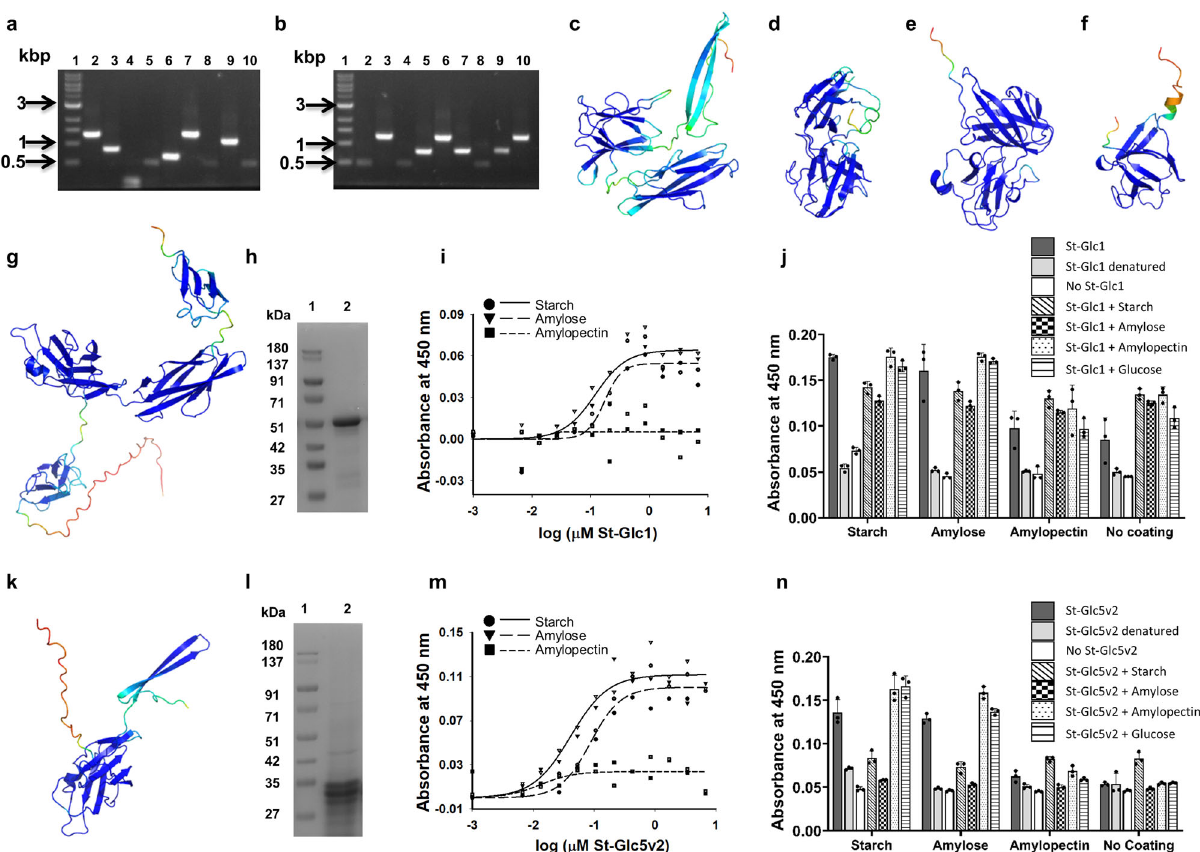
Fig. 4 Identi fi cation of starch binding protein domains. a , b Agarose gel electrophoresis of PCR amplicons indicating the presence or absence of any recombinant insert following biopanning of the metagenomic phage display library against starch. a Biopanning against starch and elution with D-glucose. Results of a single screening experiment. Lane 1: 1 kbp DNA marker. Lanes 2 – 9: PCR amplicons of clones St-Glc1 to St-Glc9. b Biopanning against starch and elution with starch. Results of a single screening experiment. Lane 1: 1 kbp DNA marker. Lanes 2 – 9: PCR amplicons of clones St-St1 to St-St9. c – f AlphaFold2 predicted structural models of St-Glc2 ( c ), St-Glc8 ( d ), St-St4 ( e ), and St-St5 ( f ). g AlphaFold2 predicted structural model of St-Glc1. h Coomassie blue stained SDS-PAGE showing puri fi ed St-Glc1 protein following Ni-NTA metal ion af fi nity chromatography; Lane 1: Protein molecular weight marker; Lane 2: Puri fi ed recombinant St-Glc1 protein. i Concentration dependent binding of St-Glc1 to immobilized starch, amylose, and amylopectin. Individual data points plotted after background subtraction along with regression curves. Results of a single binding experiment with two technical replicates. Source data in Supplementary Data 3. j Binding of St-Glc1 to wells containing immobilized starch, amylose, amylopectin, or buffer (blank) with or without pre-incubation with starch, amylose, amylopectin, or D-glucose. Results of a single binding experiment. Means are plotted as bars and individual data points included. Error bars represent standard deviations of three technical replicates. Source data in Supplementary Data 3. k AlphaFold2 predicted structural model of St-Glc5v2. l Coomassie blue stained SDS-PAGE showing puri fi ed St-Glc5v2 protein following Ni-NTA metal ion af fi nity chromatography; Lane 1: Protein molecular weight marker. Lane 2: Puri fi ed recombinant St-Glc5v2 protein. m Concentration dependent binding of St-Glc5v2 to immobilized starch, amylose, and amylopectin. Individual data points plotted after background subtraction along with regression curves. Results of a single binding experiment of two technical replicates. Source data in Supplementary Data 3. n Binding of St-Glc5v2 to wells containing immobilized starch, amylose, amylopectin, or buffer (blank) with or without pre-incubation with starch, amylose, amylopectin, or D-glucose. Results of a single binding experiment. Means are plotted as bars and individual data points included. Error bars represent standard deviations of three technical replicates. Source data in Supplementary Data